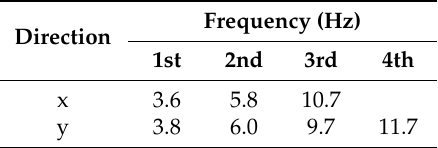
Table 6. Vibration frequencies of the